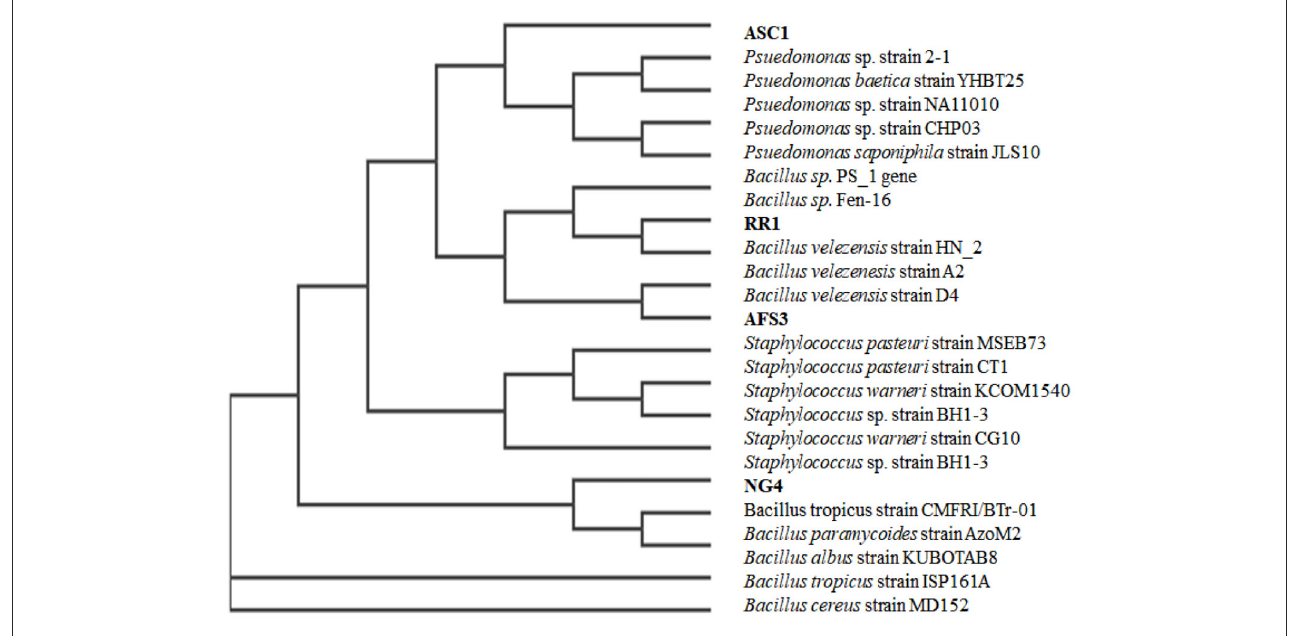
FIGURE5 Phylogenetic tree constructed using the 16S rRNA gene sequences of the four selected isolates and some of their nearest phylogenetic taxa.